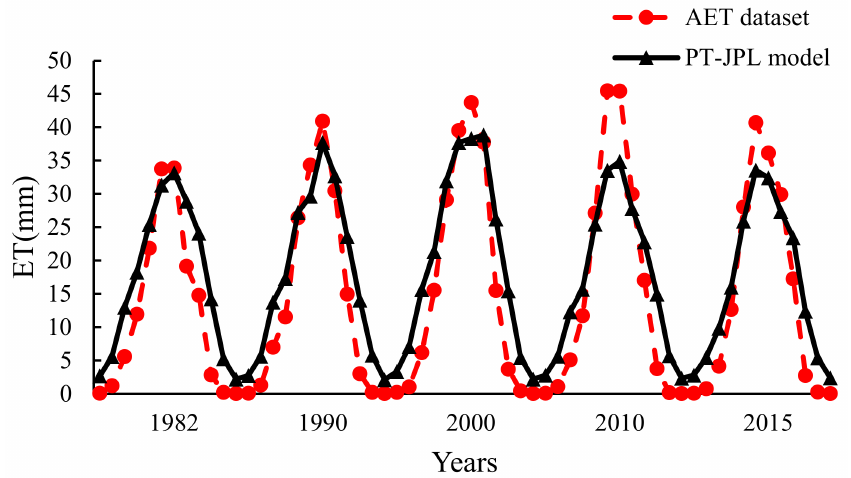
Figure 3. Comparison of annual evapotranspiration data of the AET dataset and the PT-JPL model in southern Xinjiang from 1982 to 2015.